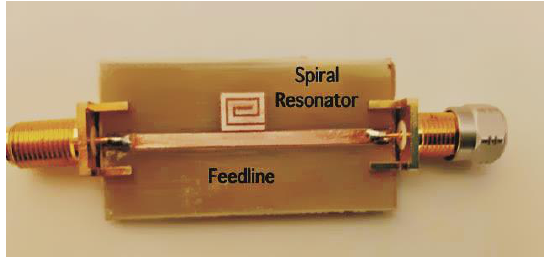
Figure 5. Photo of a single-bit tag Figure 5 Photo of a single-bit tag structure. Figure 5 Photo of a single-bit tag structure.